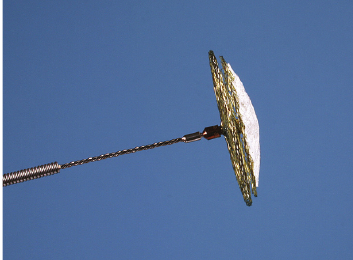
Figure 2: View of the Occlutech Figulla PFO device (23/25mm) prior to